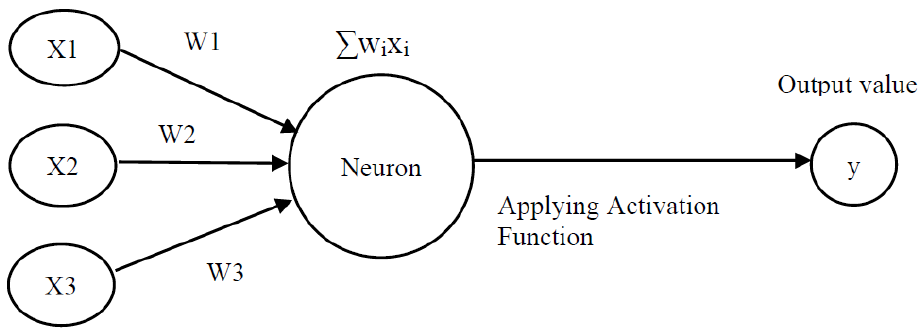
Figure 4. General structure of ANN.